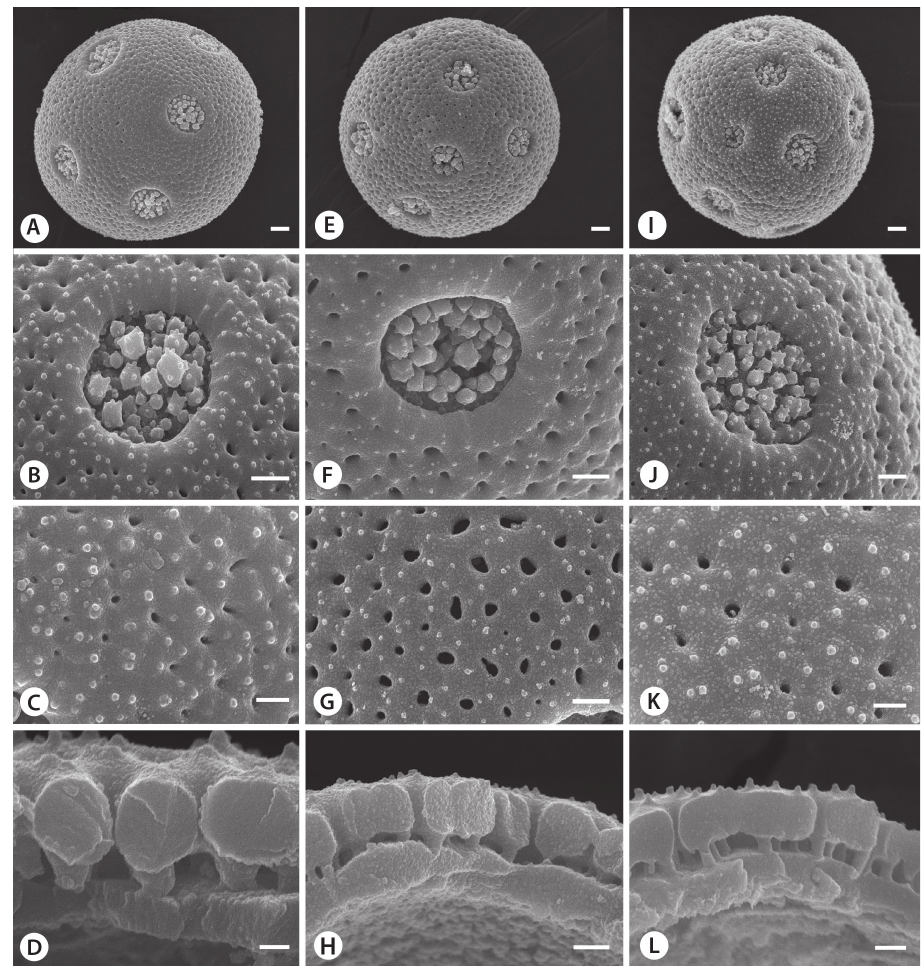
Figure 3. Pollen diversity in Altingiaceae. A–D Liquidambar excelsa E–h Liquidambar gracilipes I–L Liquidambar styraciflua A Pentaporate, spheroidal pollen grain B Details of pore showing the characteristic disintegration of the tectum C Details of the tectal surface displaying scabrae and ir- regularly-shaped perforations D Details of tectate-columellate exine, note columellae slightly thicker than those of comparable magnification in h and E Pentaporate, spheroidal pollen grain F Details of pore showing the characteristic disintegration of the tectum g Details of the tectal surface display- ing scabrae and irregularly-shaped perforations h Details of tectate-columellate exine with thinner columellae than in D of Liquidambar excelsa I Pentaporate, spherical pollen grain J Details of circular pore showing eroded tectum in the pore proper K Details of tectal surface with irregularly-shaped perforations and scabrae L Details of the tectate-columellate exine with thin columellae as compared to Liquidambar excelsa in D . Scale bars: A, E, I = 2 µm, scale bars: B, F, G, J = 1 µm, scale bars: C, H, K, L = 500 nm, scale bar: D = 200